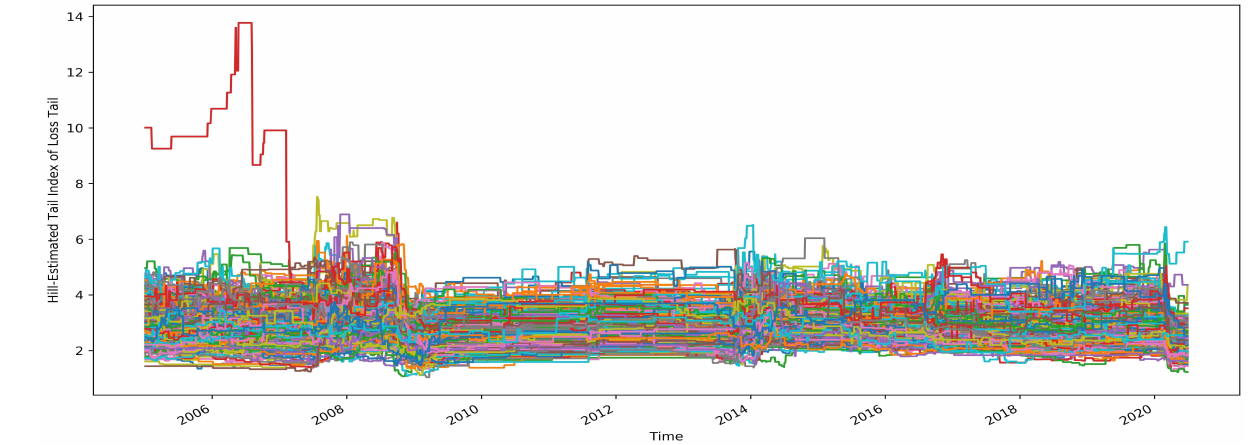
Figure 2. Tail indices estimated by Hill estimator for 361 S&P500